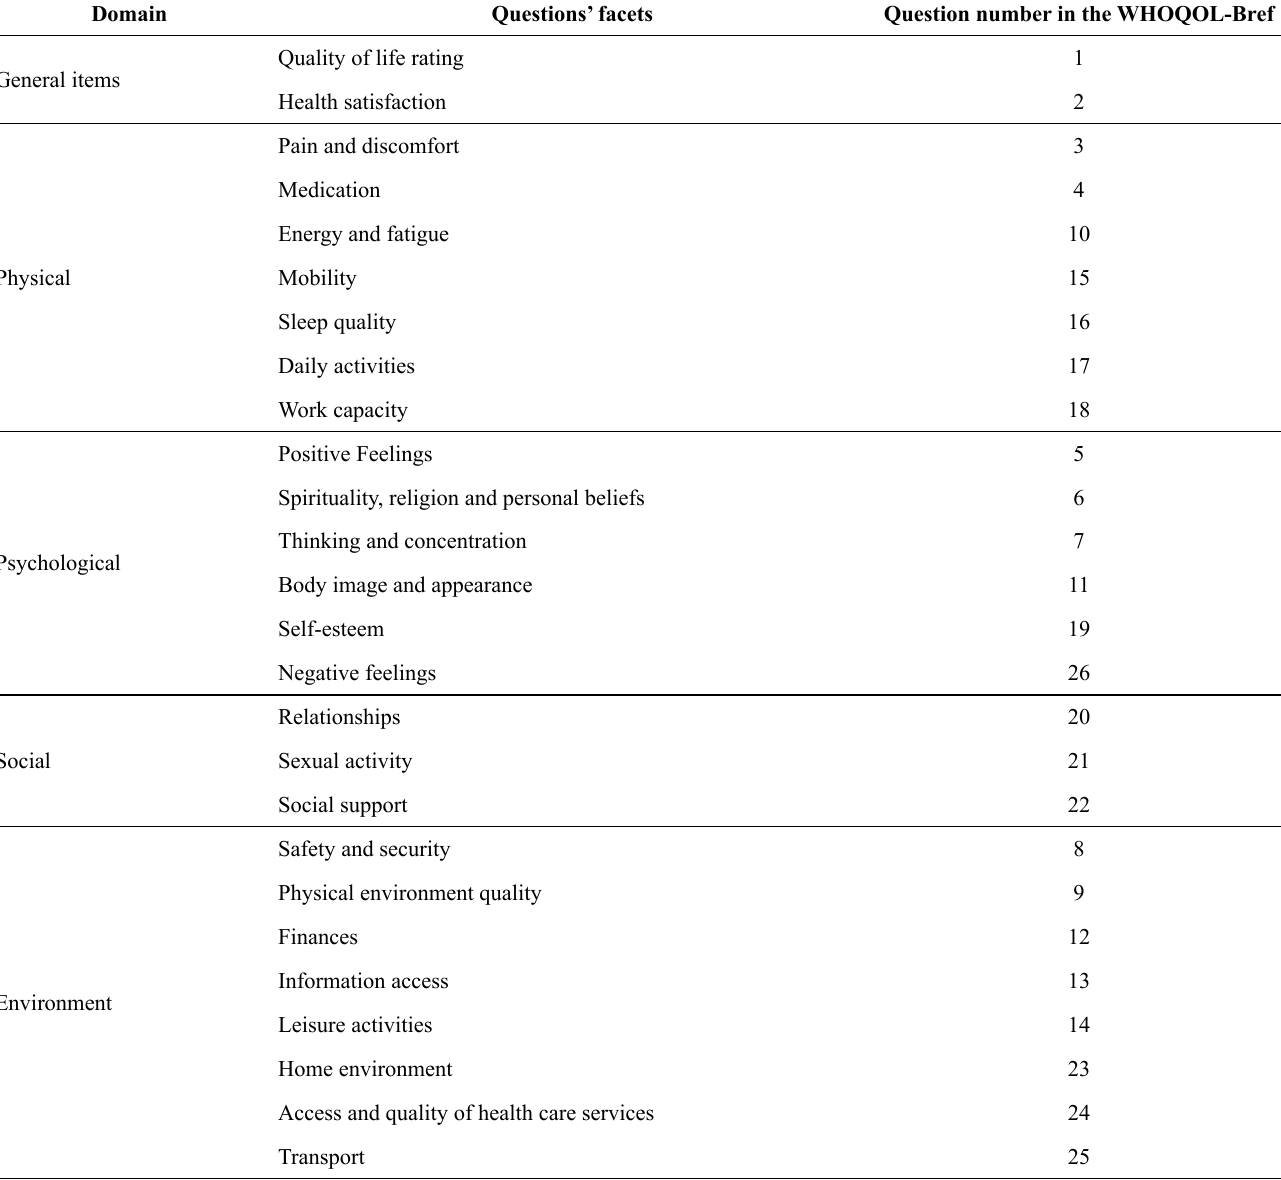
Table 2. WHOQOL-Bref’s facets according to the domains and the number of the question it appears